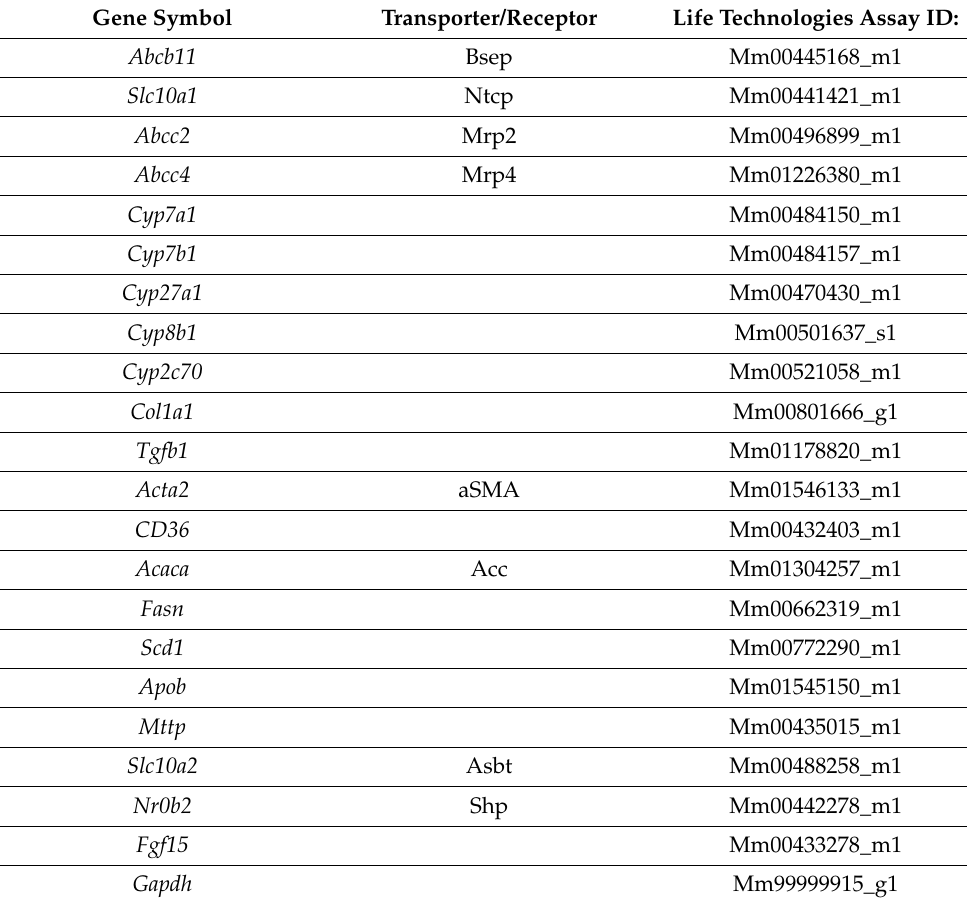
Table 1. Predesigned TaqMan ® gene expression assay kits (Life Technologies, Carlsbad, CA, USA) used for quantitative real-time RT-PCR.